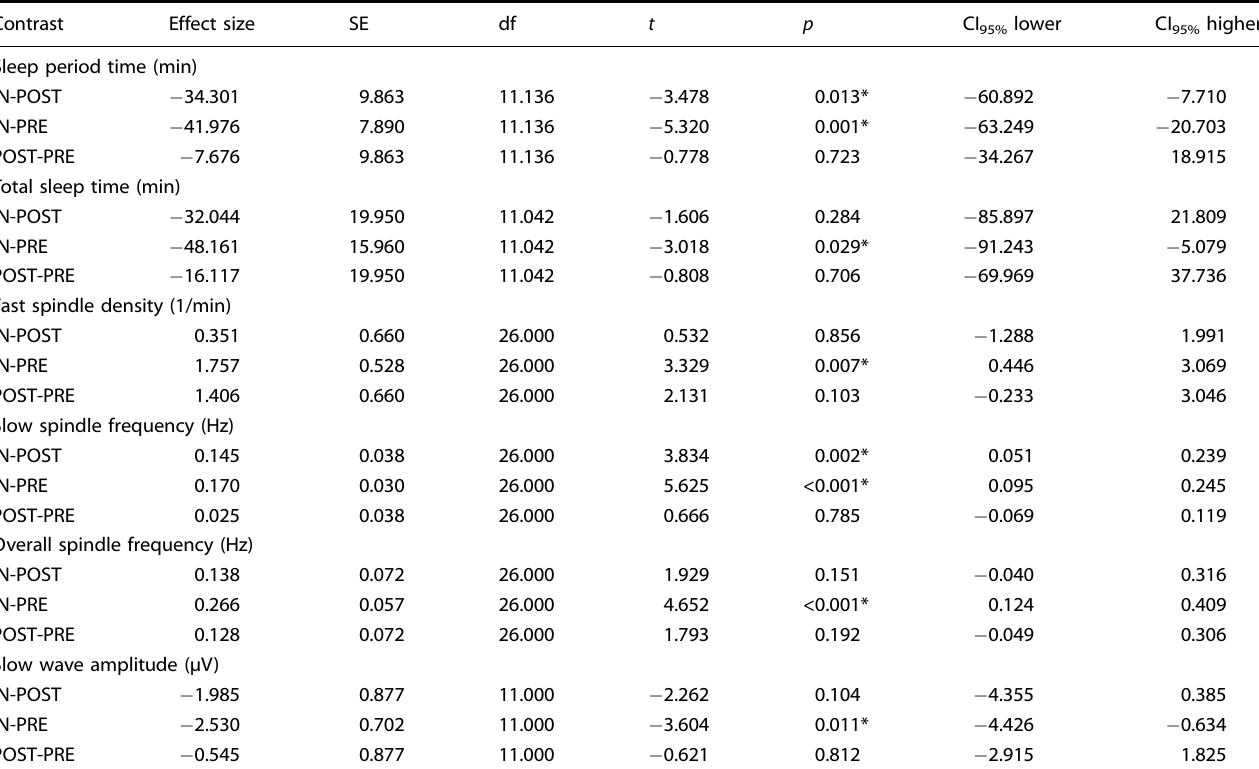
Table 1. Summary of post hoc estimated marginal means contrasts following a signi fi cant effect in the linear mixed-effects models.